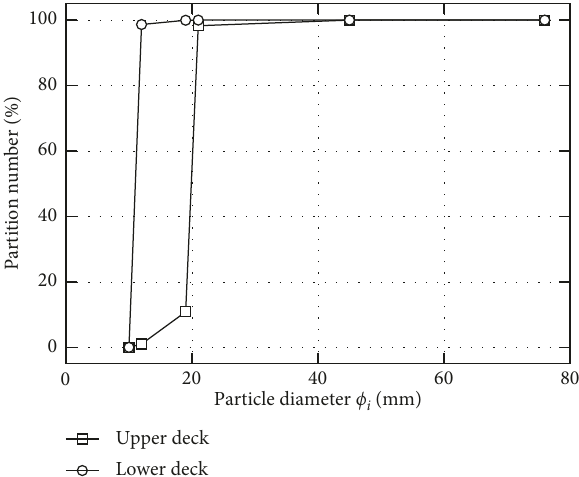
Figure 7: Partition curves of the overflow for the upper and lower decks.